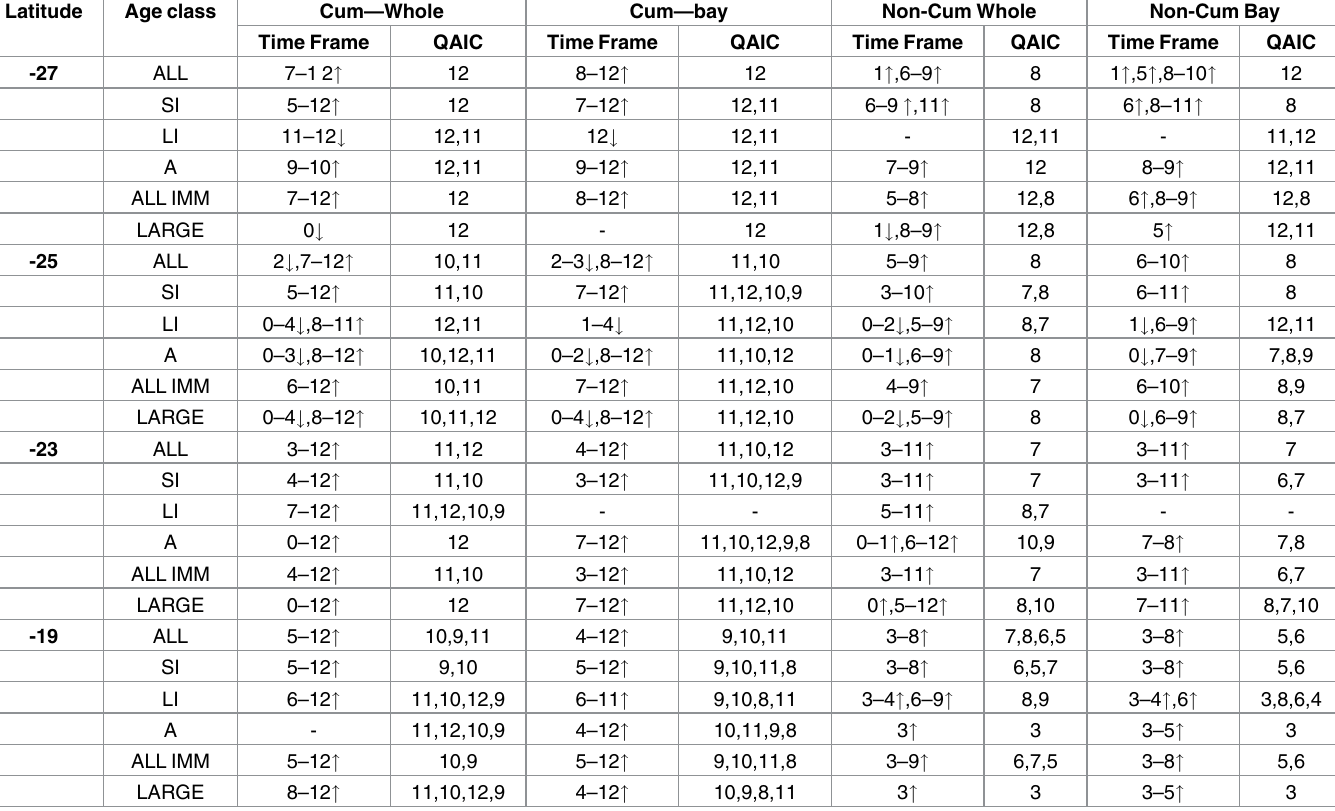
Table 4. Model results for green turtles and mean discharge. " denotesincreasedstrandingsrates with increaseddischarge. # denotes decreased strandingrates with increaseddischarge. Age class abbreviations: ALL = all turtles, SI = small immature, LI = large immatures, A = adult-sized, ALL IMM = all immature sized animals(small + large), Large = all large turtles (large immatures + adult-sized). The time frame is reportedin monthly ranges where responses were noted. The values reportedin qAIC are the months with the most significantqAIC